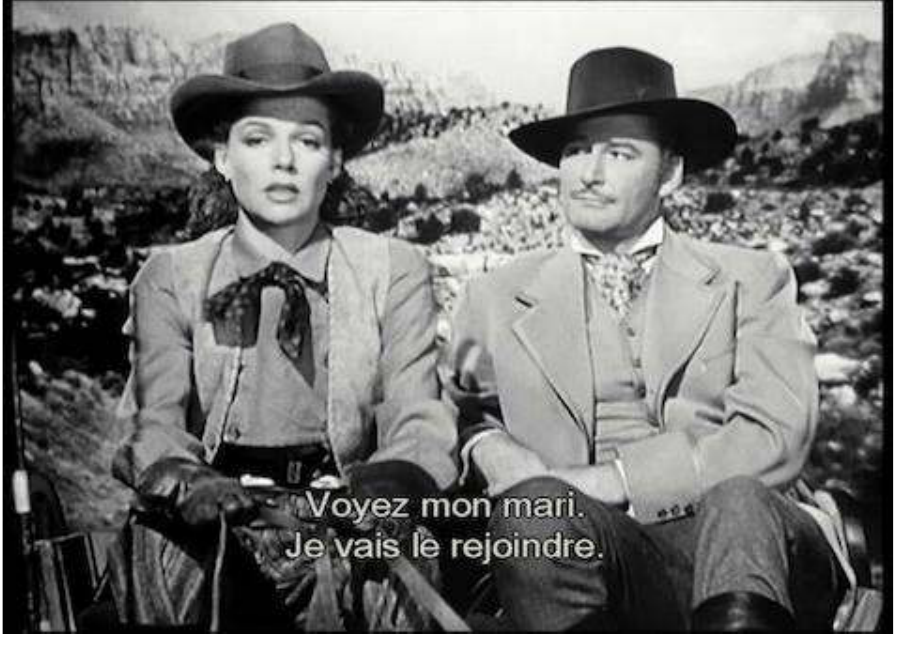
Figure 20: Georgia driving a buggy in Silver